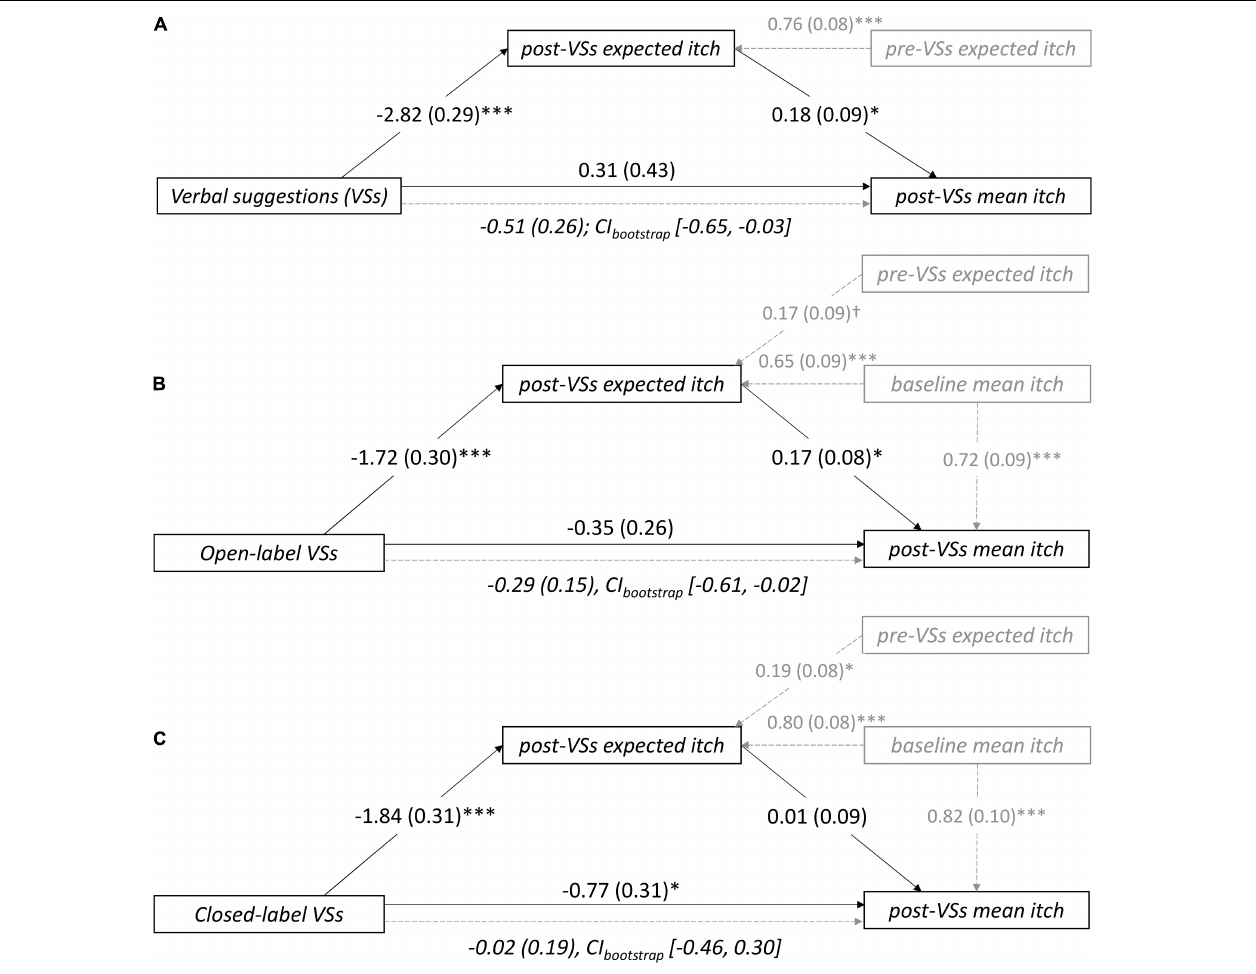
FIGURE 2 | Unstandardized regression coefficients (SEM) for the mediation of the association between verbal suggestions (VSs) and post-VSs mean itch by itch expectations in (A) study 1, (B) the open-label arm of studies 2–3, and (C) the closed-label (i.e., concealed) arm of studies 2–3. The models were controlled for pre-VSs itch expectation (A–C) and baseline itch (B,C) . Note that c = (indirect) mediation effect; CI bootstrap = bootstrapped confidence interval; † p < 0.10; * p < 0.01; ∗∗∗ p < 0.001.